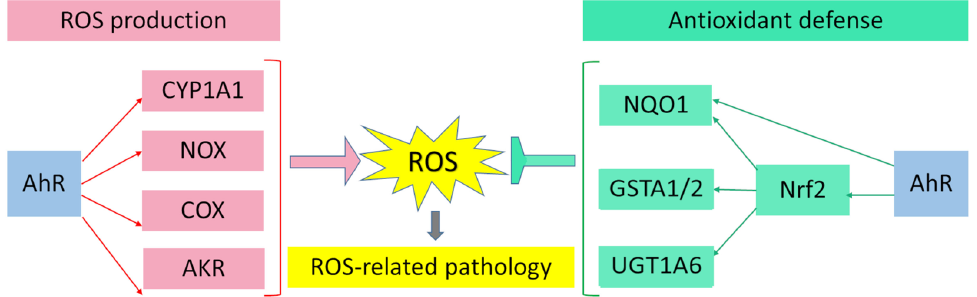
Figure 4. Pro-oxidant and antioxidant effects of AhR results in wide range of physiological and pathological processes in cells and tissues.